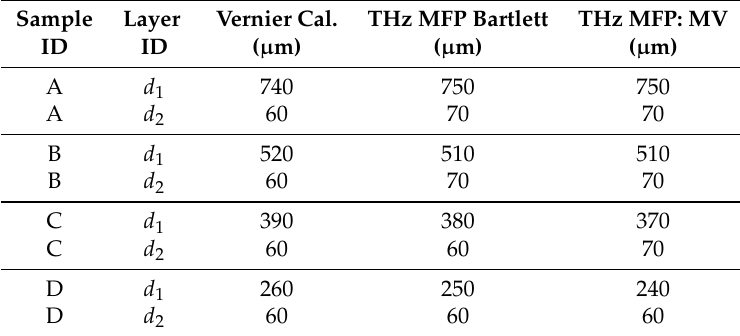
Table 2. Thickness estimates obtained from THz MFP with the Bartlett and MV objective functions for the experiment configuration shown in Figure 1. All of the differences between the THz MFP results and the Vernier caliper measurements are within the measurement resolution of the Vernier caliper (20 µ m). Sample Layer Vernier Cal. THz MFP Bartlett THz MFP: